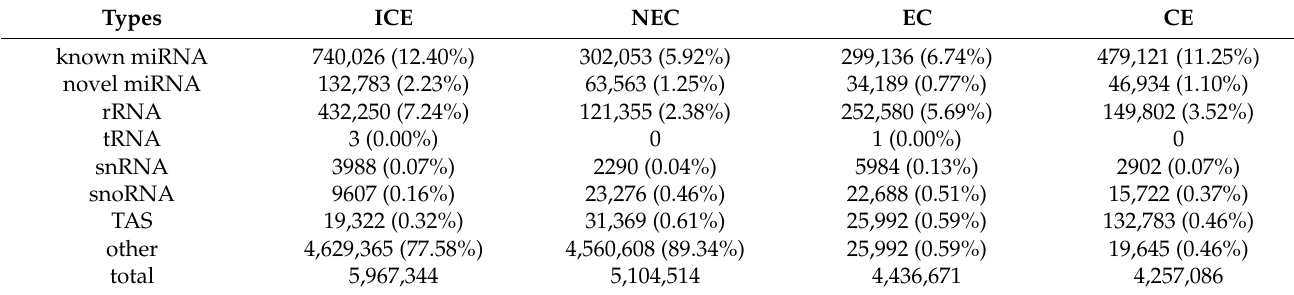
Table 3. Annotation of small